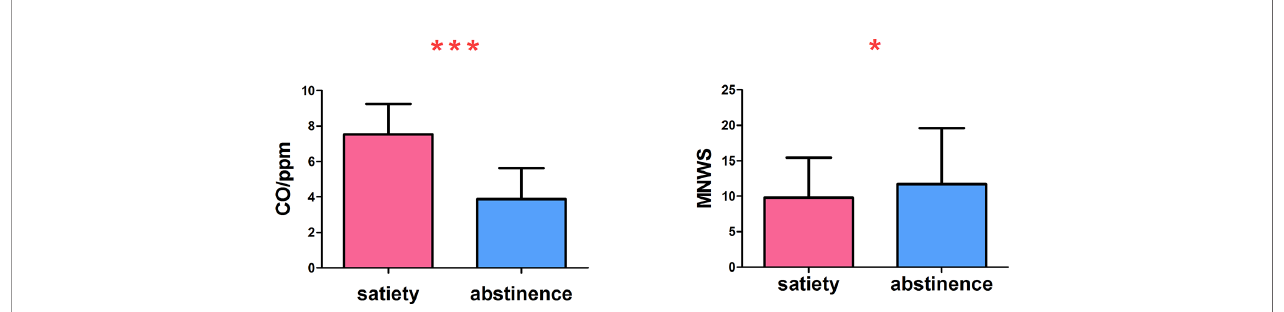
FIGURE 2 | The carbon monoxide in expired air was signi fi cantly reduced and the withdrawal symptoms increased *p < 0.05, ***p < 0.001. * and *** Represents that there were signi fi cant differences in CO level and withdrawal symptoms between satiety and abstinence in smokers.